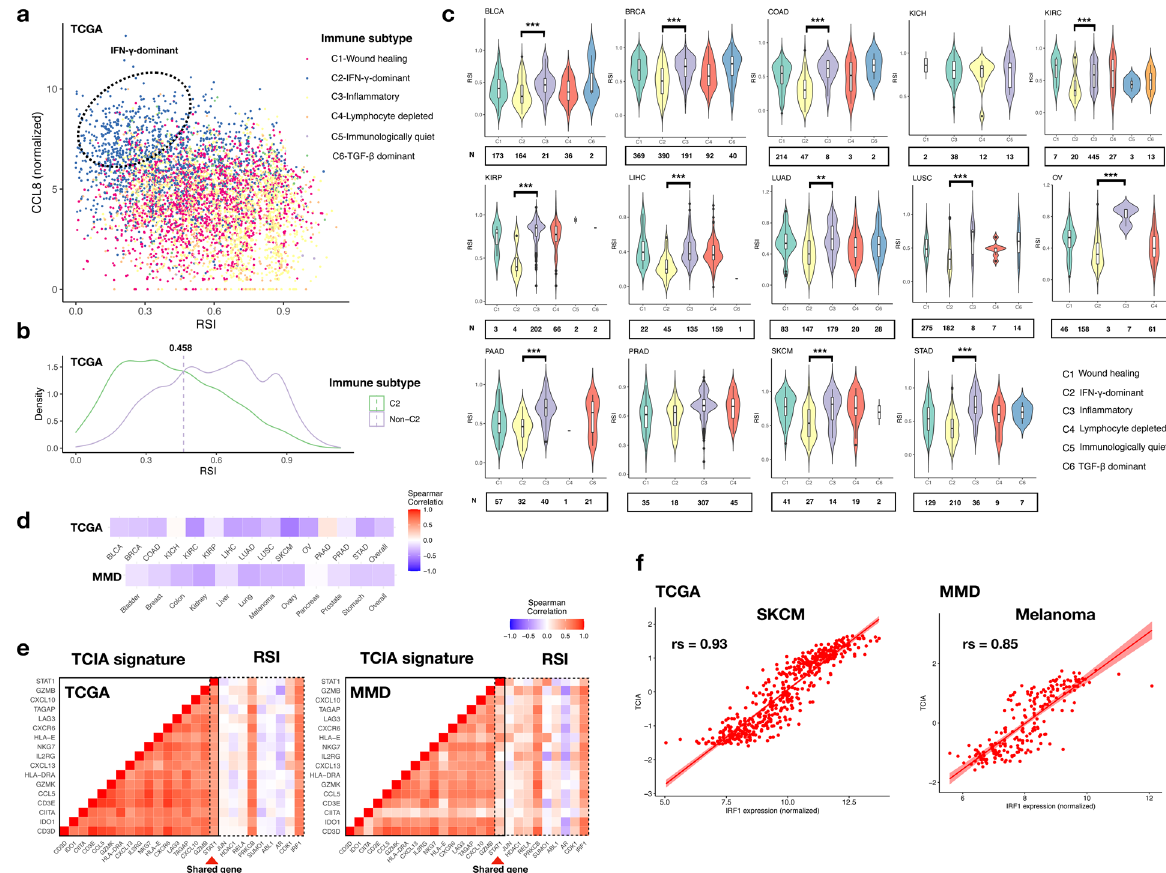
Fig. 3 RSI and immune landscape. a Scatter plot showing distribution of six immune categories along axes of RSI and CCL8 . C1, C2, C3, C4, C5, and C6 denote wound healing, IFN- γ -dominant, in fl ammatory, lymphocyte-depleted, immunologically quiet and TGF- β -dominant pathways, respectively. Dotted circle indicates clustering of the C2 subtype. b Density plot showing distribution of RSI in C2 and non-C2 categories. Dotted line indicates the optimal cut-off value. c Distribution of RSI in TCGA cohorts separated by immune subtypes. The black horizontal lines represent the median. d Spearman ’ s correlation between RSI and TCIA across the 11 cancer types in TCGA (upper panel) and MMD (lower panel). Colour bar indicates Spearman ’ s rho. e Matrix heatmap of Spearman ’ s correlation between the 18 TCIA genes and 10 RSI genes in TCGA (left panel) and MMD (right panel). Red arrowhead indicates the overlapped gene between TCIA and RSI. Colour bar indicates Spearman ’ s rho. f Correlations between IRF1 expression and TCIA